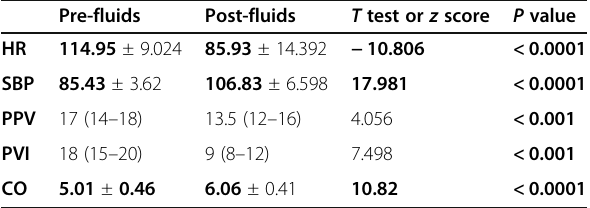
Table 1 Hemodynamic, PVI, PPV, and CO variables before and after fluid bolus Pre-fluids